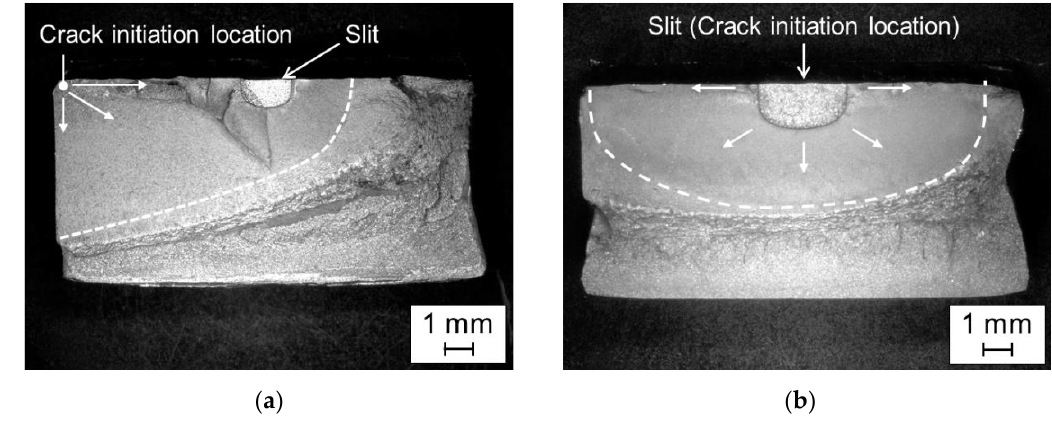
Figure 7. Fracture surfaces of ( a ) WNS1.0 at σ a = 260 MPa and ( b ) WNS1.5 at σ a = 220 MPa observed using a digital optical microscope.